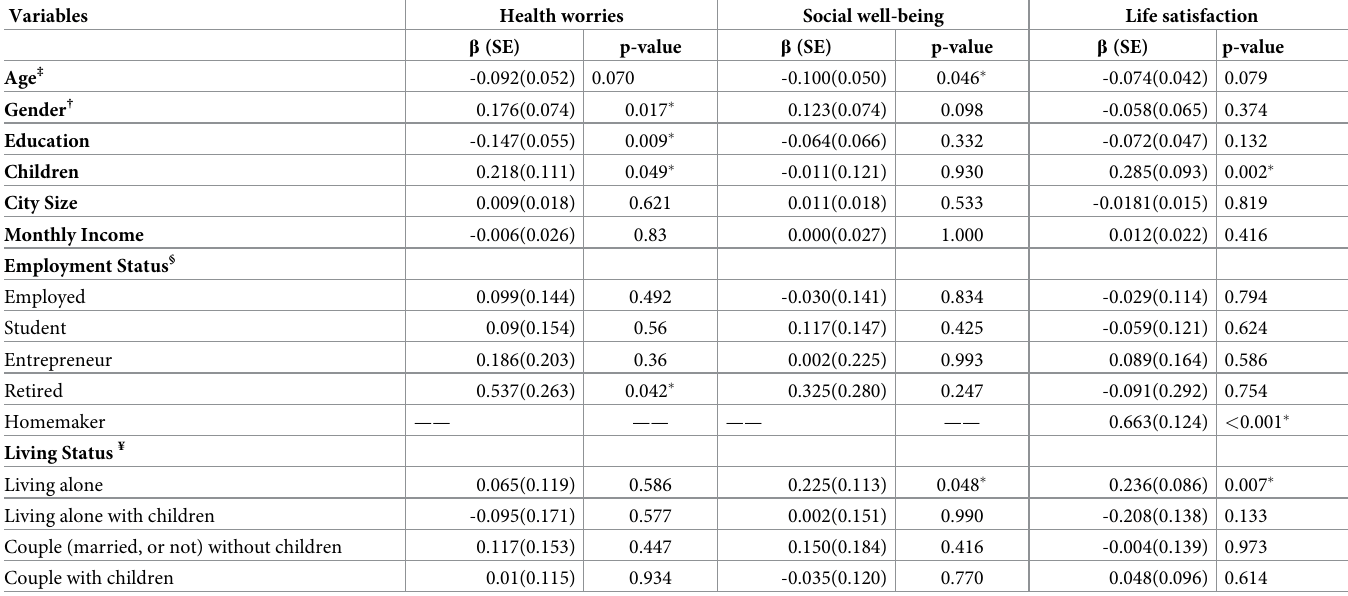
Table 3. Linear regression models for mental well-being outcomes in terms of sociodemographic